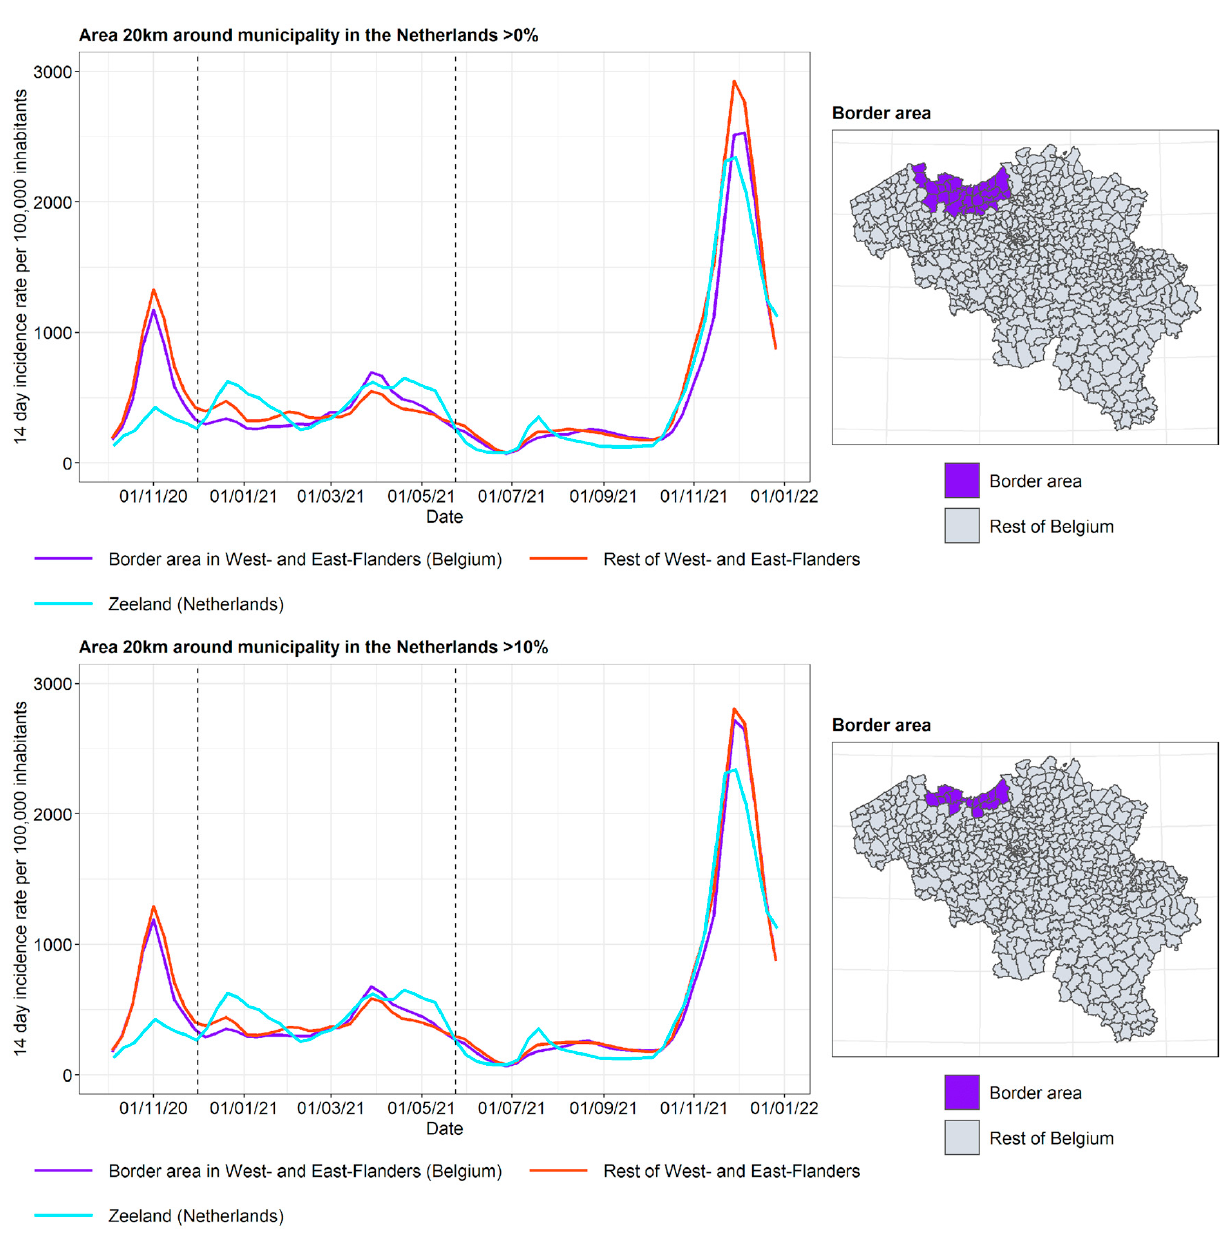
Figure 9. COVID-19 incidence curves for the border area of West and East Flanders and Zeeland. Selected period for the summary measures in Figure 10 is denoted by vertical dashed lines.